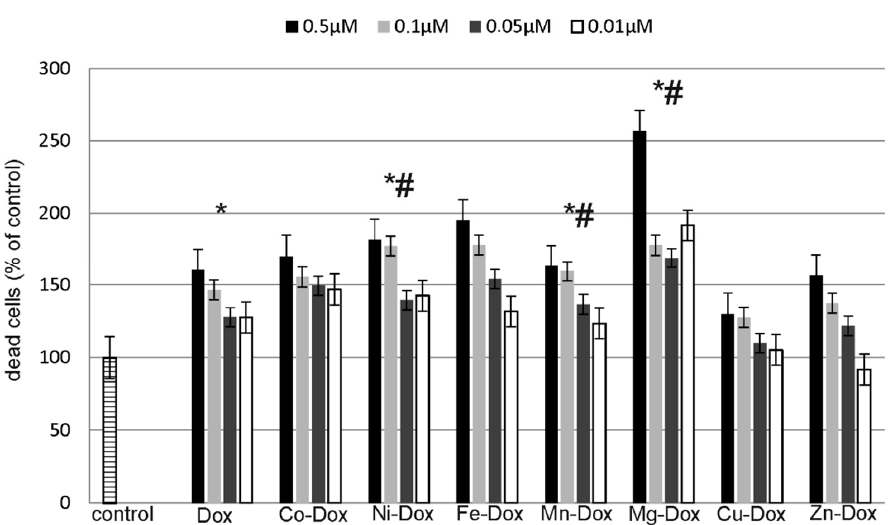
Figure 9. DOX, Cu-DOX, Zn-DOX, Co-DOX, Ni-DOX, Fe-DOX, Mn-DOX and Mg-DOX cytotoxicity in MCF-7 cells. The cells were incubated with 0.5 µM, 0.1 µM, 0.05 µM and 0.01 µM DOX and Metal-DOX complexes for 24 h. Mean values from five independent experiments ± SD are shown. Significant alterations are expressed relative to control untreated cells (marked with asterisks *) and to DOX—controls (marked with crosses #). Statistical significance was considered if #* p < 0.05.